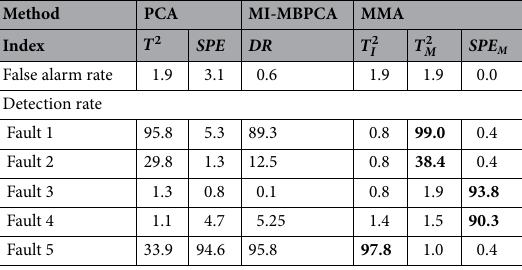
Table 1. False alarm rates (%) and detection rates (%) of the principal component analysis (PCA) method, the mutual information–multiblock PCA (MI-MBPCA), and the minimalist module analysis (MMA)